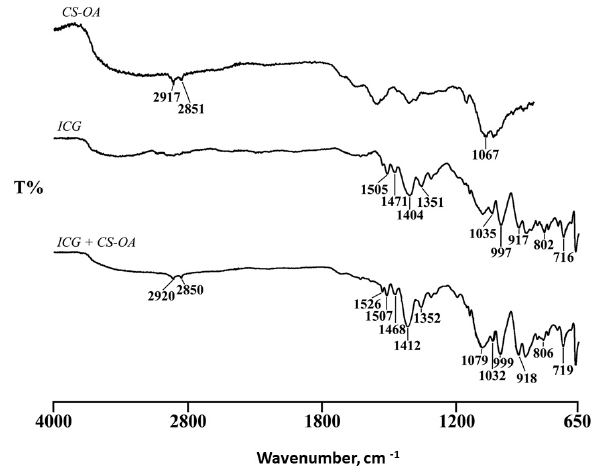
Figure 6. FTIR spectra of the CS-OA, ICG and their interaction product at a 0.2:1 molar ratio.